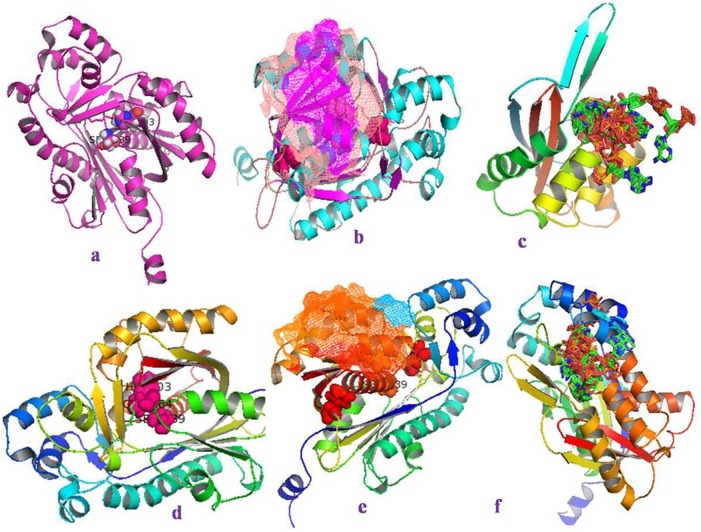
Predicted three-dimensional models and ligand-binding sites of GaCHSs.Ribbon model display of the three-dimensional structures of GaCHS1 and GaCHS2 with conserved catalytic triad (Cys-His-Asn) shown in the central core of the structures (a and d);Ribbon model display of the three-dimensional structures of GaCHS1 (b) and GaCHS2 (e) as predicted by I-TASSER web server, showing geometry of active site a malonyl-CoA binding motif shown as mesh structures and gatekeepers Phe215and Phe265 (Pink in GaCHS1 and Red in GaCHS2). The ligand binding sites as predicted by 3DLigandSite web server are depicted in the ribbon model (c and f). The predicted ligand binding sites for GaCHS1 are Ala211, Gln212, Ala213, Leu214, Phe215, Ile254, Phe265, Leu267, Lys269, Val271, Pro272, Gly305, Gly306, Ala308, Ile309, Ile336 and for GaCHS2, the predicted ligand binding sites were Lys55, Phe56, Asp57, Leu58, Ser59, Ala60, Val62, Thr63, Ile64, Leu164, Leu206, Asp207, Leu209, Val210, Gly211, Leu214, Phe215, Ile254, Phe265, Leu267, Lys269, Val271, Pro272, Gly305, Gly306, Ala308, Asn336.